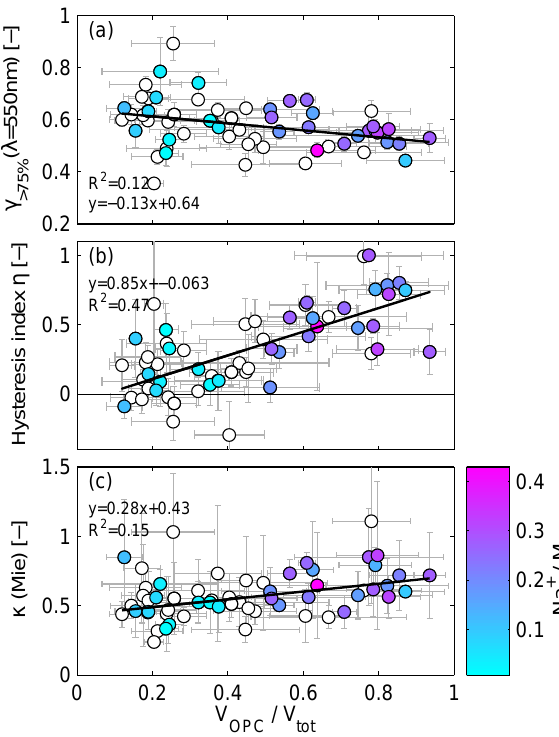
Fig. 8. (a) : Fit-parameter γ > 75% of f ( RH) versus the volume frac- tion of large particles ( V OPC /V tot ). (b) : Hysteresis index η ver- sus V OPC /V tot . (c) : Retrieved κ (retrieved at RH = 85%) versus V OPC /V tot . Color code in all panels indicates the Na + -mass frac- tion determined from filter measurements (only for days where the mole fraction 0 . 3 < Na + / Cl − < 3). Black lines represent a weighted least-square regression.